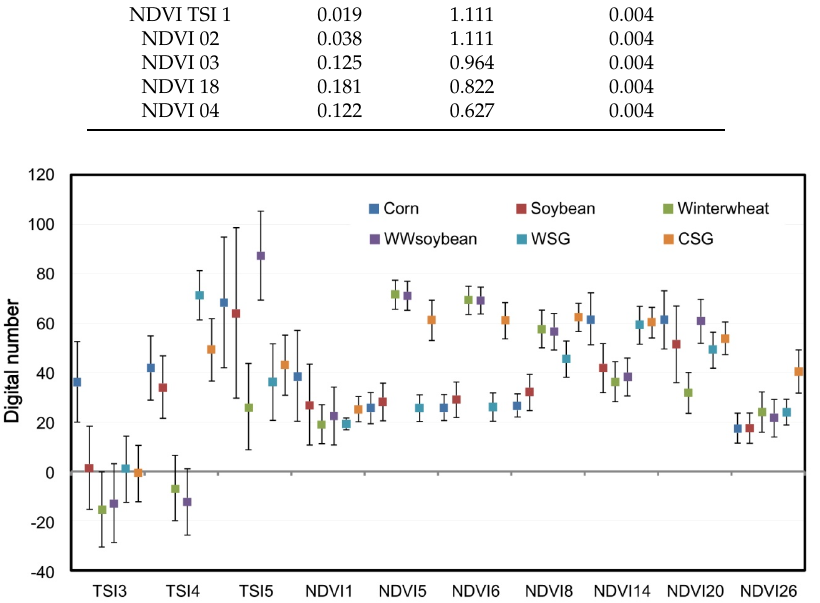
Figure 5. Means (square) and standard deviations (short line) of the 10 selected features. Calculated from the training samples of each crop.